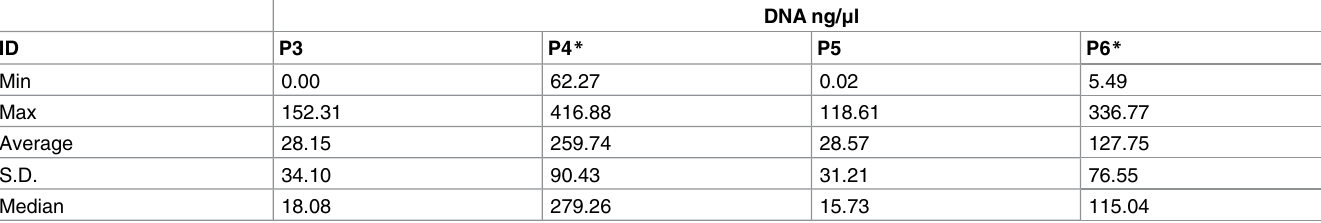
Table 5. Statistics of photometric determination of DNA